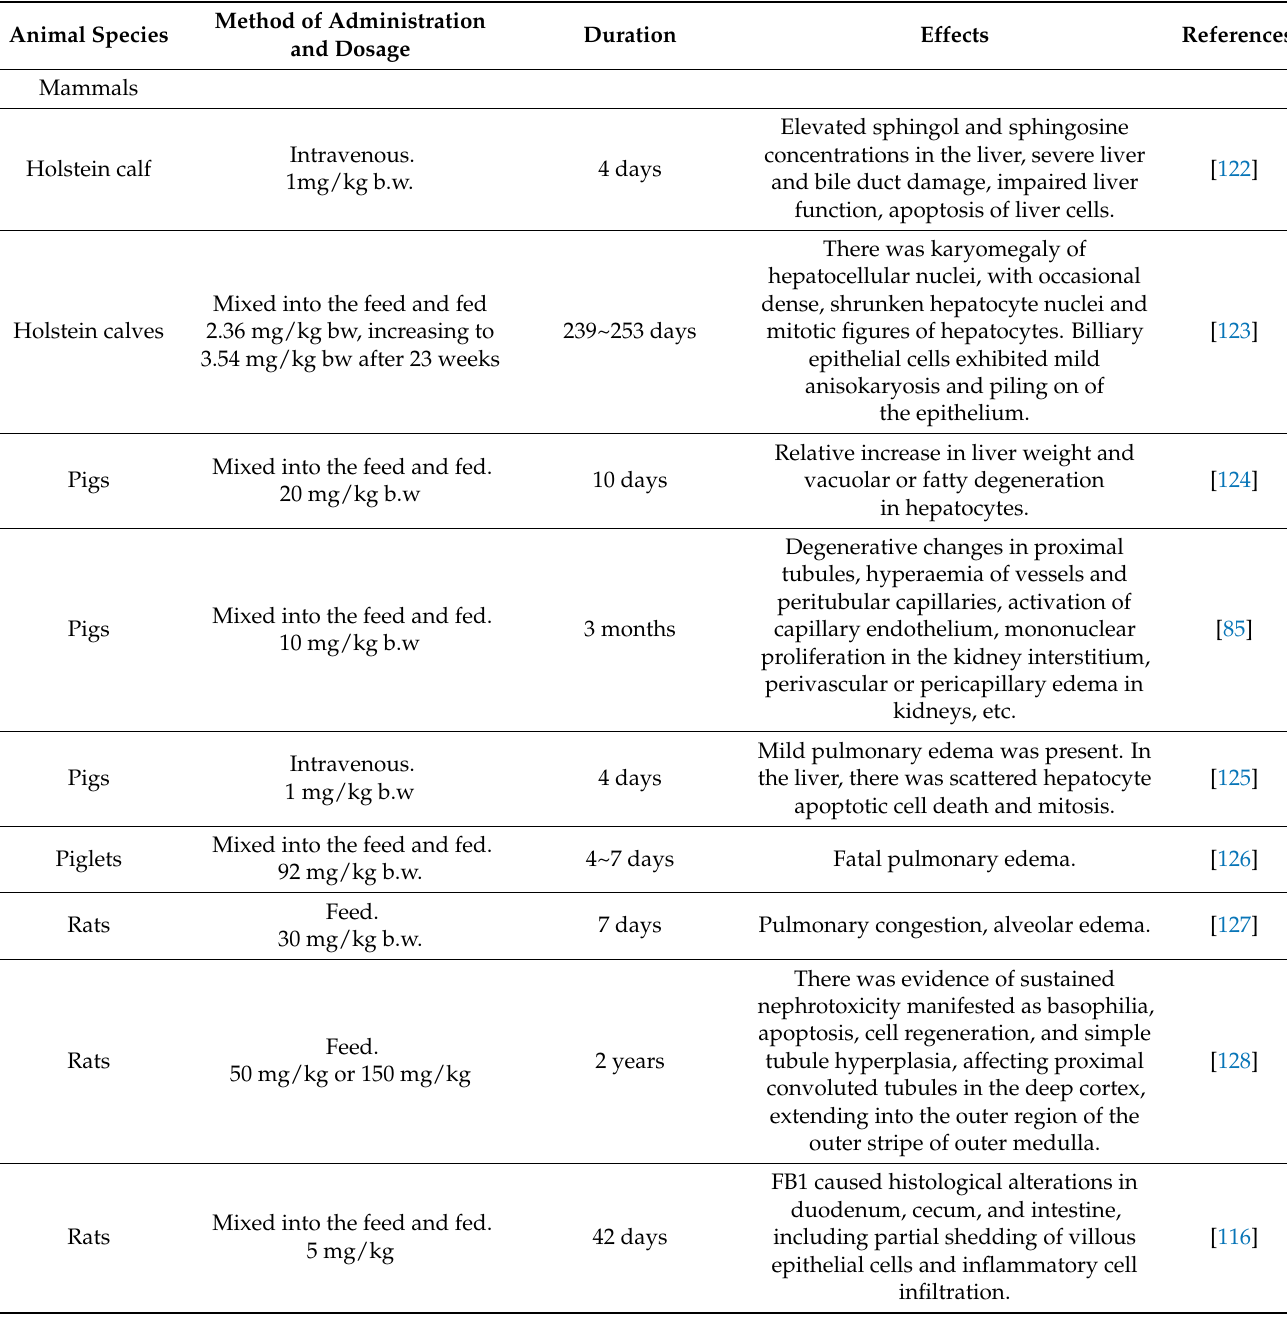
Table 4. FB1 organotoxic effects in various